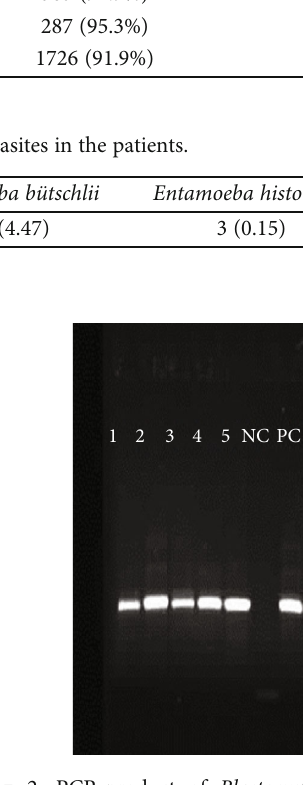
Figure 2: PCR-product of Blastocystis isolates. Lanes 1 to 5: Blastocystis isolates; lane NC: negative control; lane PC: positive control; DNA ladder,